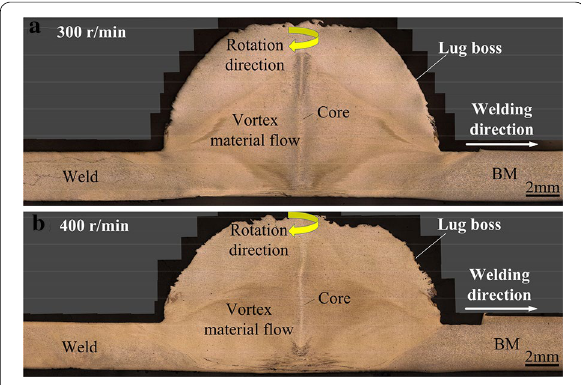
Figure 6 Macrostructure of the vortex material flow: a 300 r/min; b 400 r/min Figure 7 Microhardness map on the weld transverse